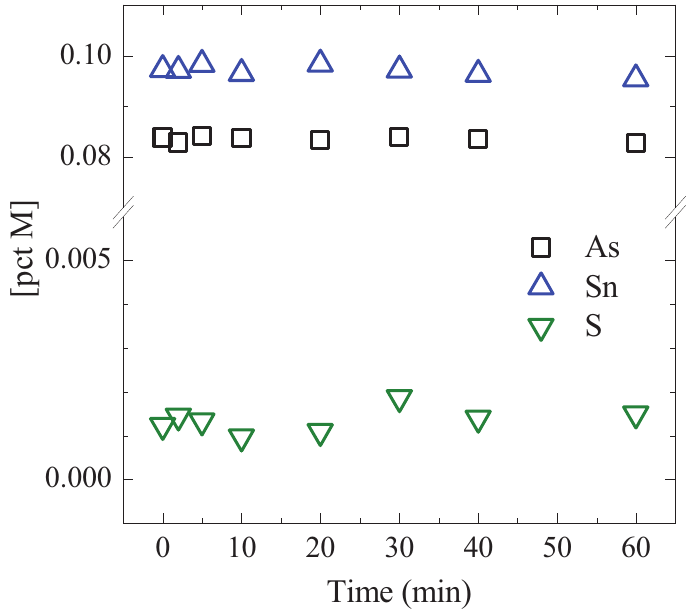
Figure 1. Results of the preliminary experiment on the evaporation of As and Sn in a C-saturated liquid iron at 1400 ◦ C. (color